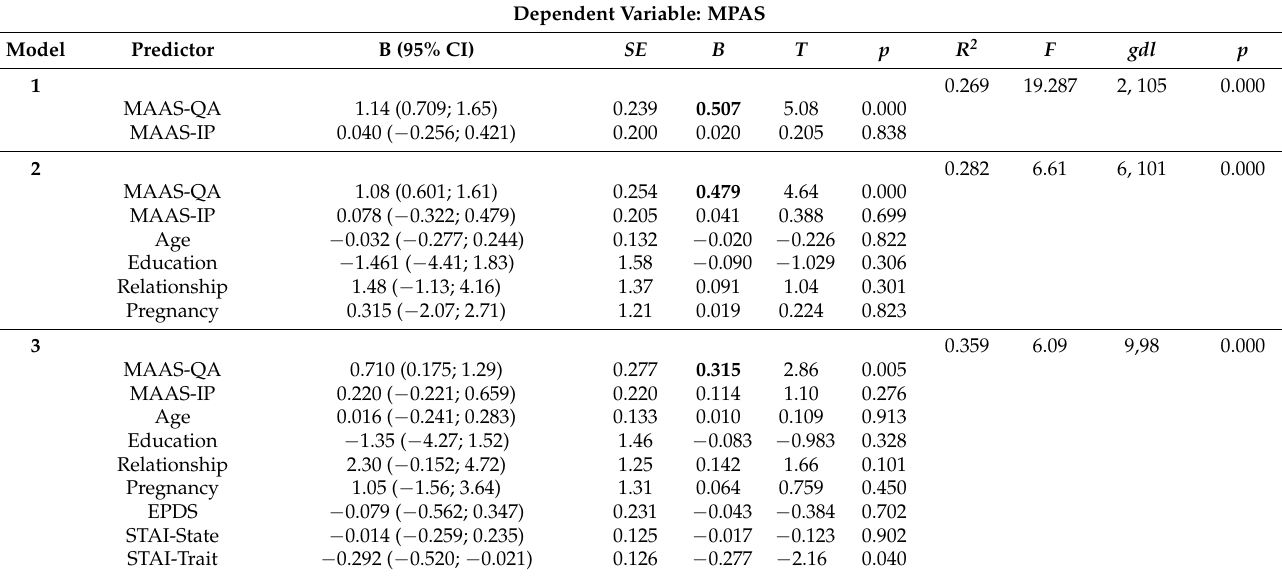
Table 3. Hierarchical multiple regression models and MAAS subscales’ effects on MPAS, controlling for the confounding